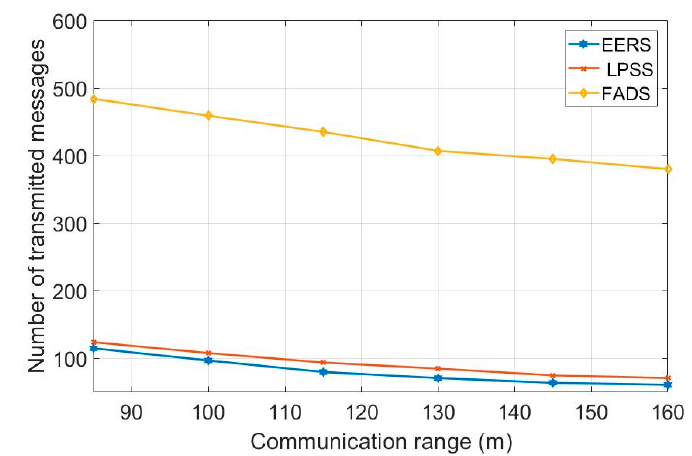
Figure 4. Required number of messages for reference node scheduling process (r = 85 m: 160 m, N = 240).